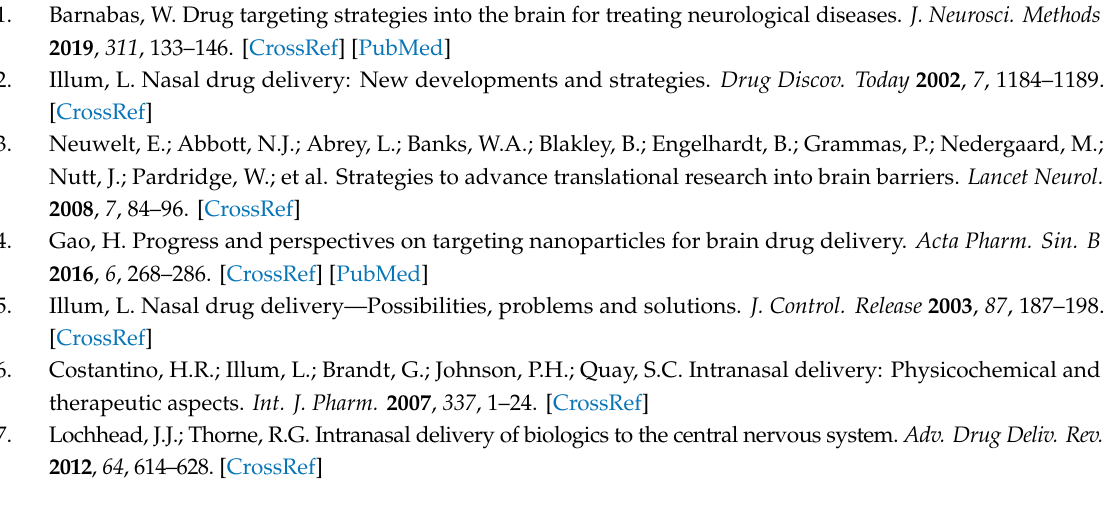
Figure S1: Permeation data referenced to control without cells vs. referencing to total FITC-dextran, Video S1: Beating cilia in submerged OEPC